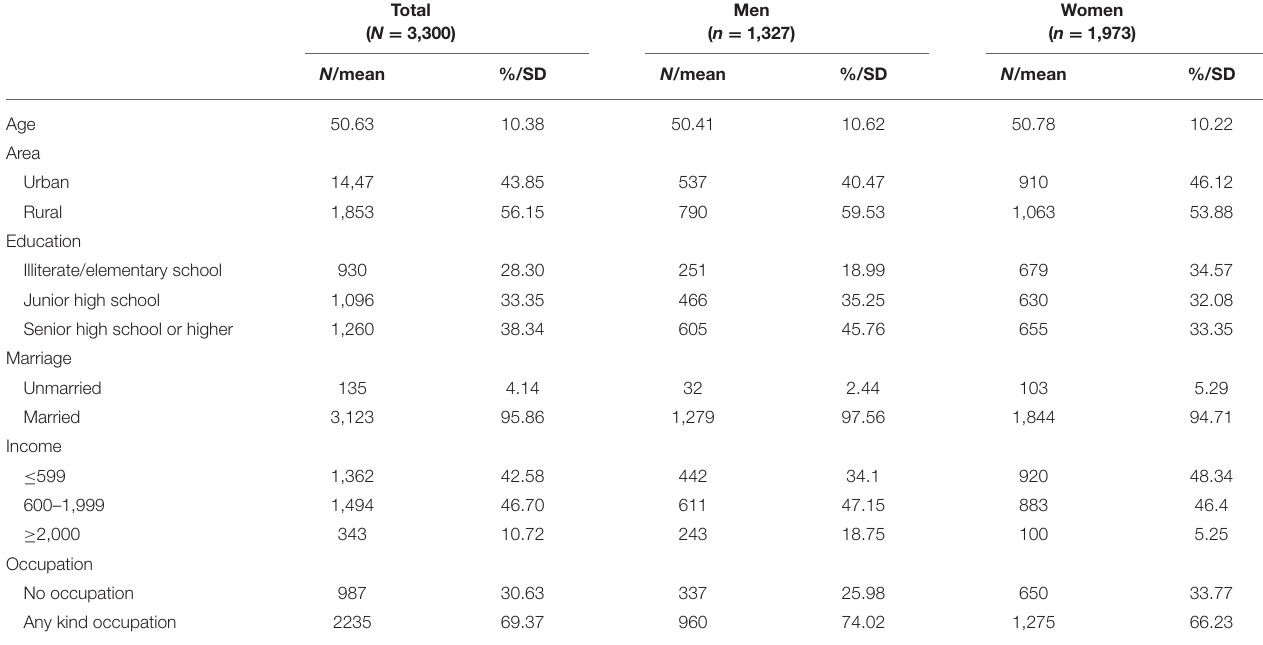
TABLE 1 | Socio-economic and demographic characteristics of analysis subjects.